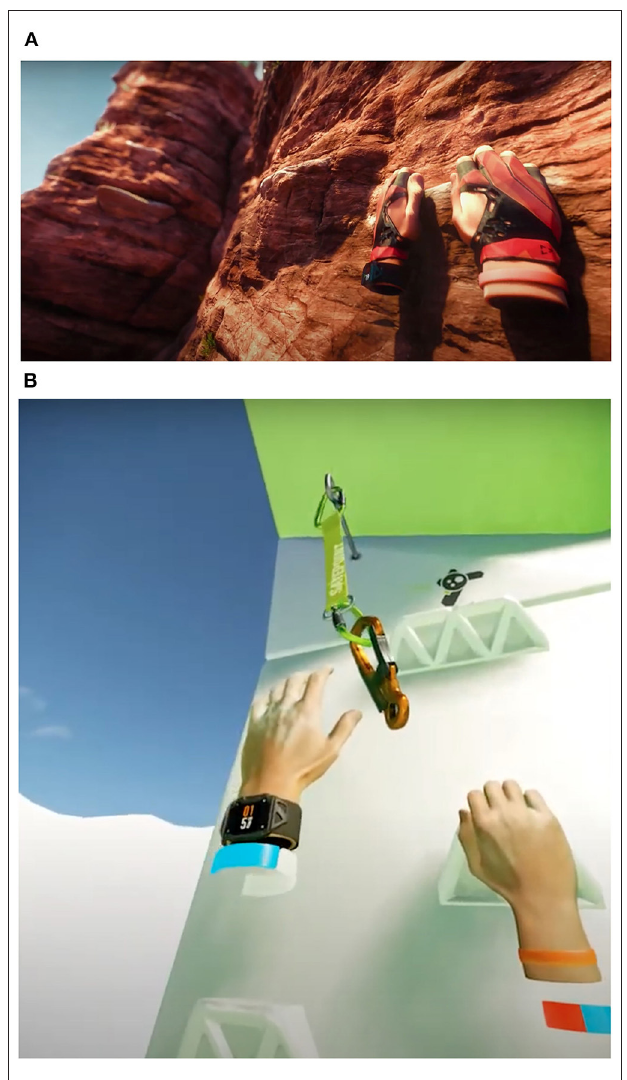
FIGURE 2 | (A) Climbing environment through headset; (B) Hand visualization during practice, showing the grips, clip, and energy bar (bottom